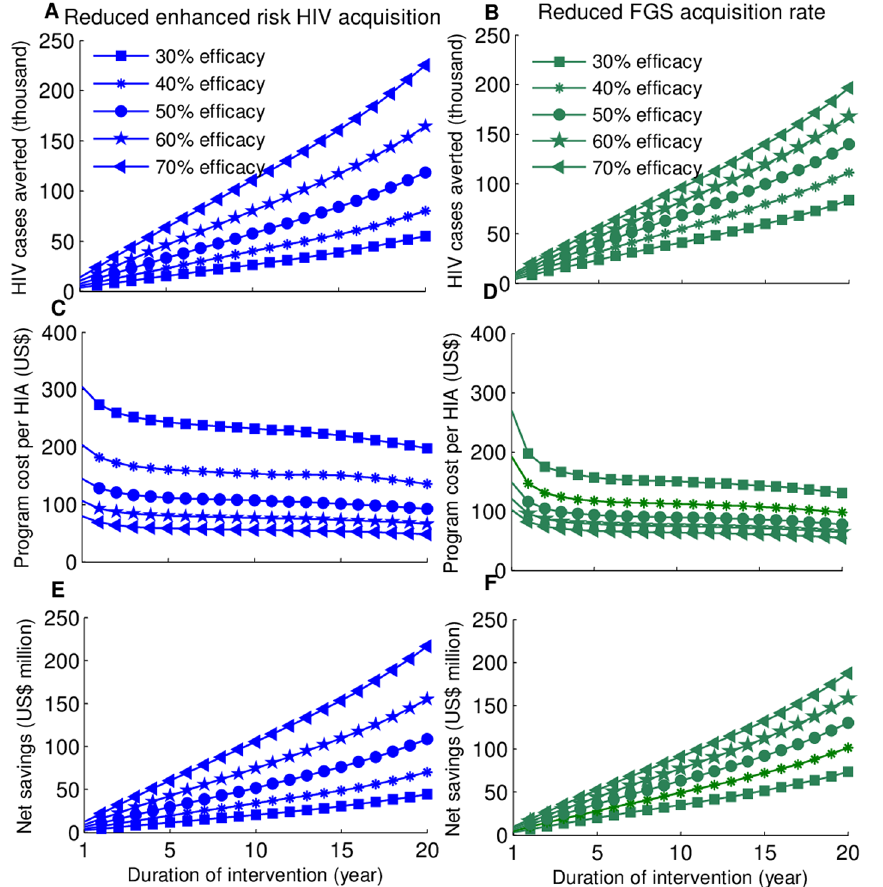
Figure 3. Cost-effectiveness of school-age intervention for the base case analysis. The number of HIV cases averted (A,B), the cost per HIV cases averted (C,D), and the net savings (E,F) were computed for different efficacies of mass praziquantel administration in reducing FGS (B,D,F) and the mitigated risk of HIV infection per sexual act (A,C,E).